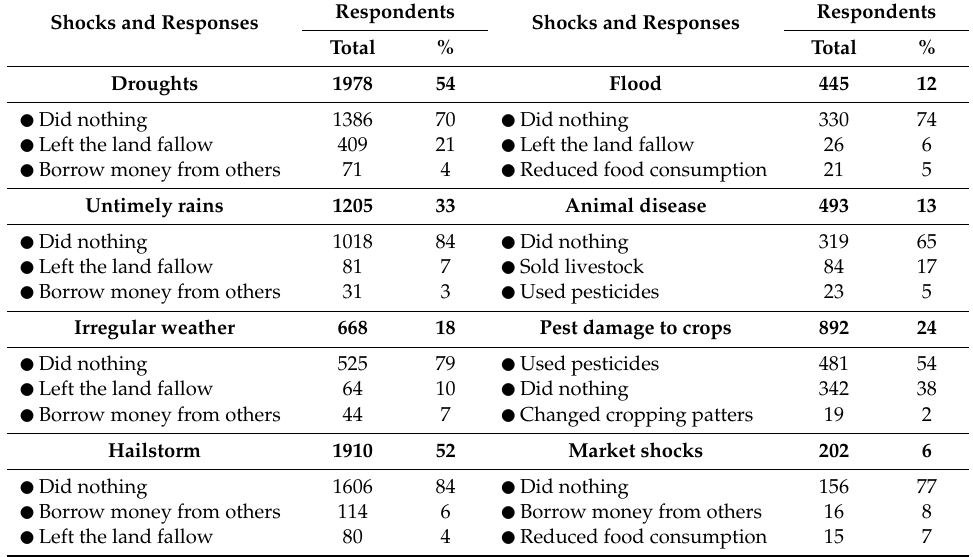
Table 4. Top three responses for each shock.